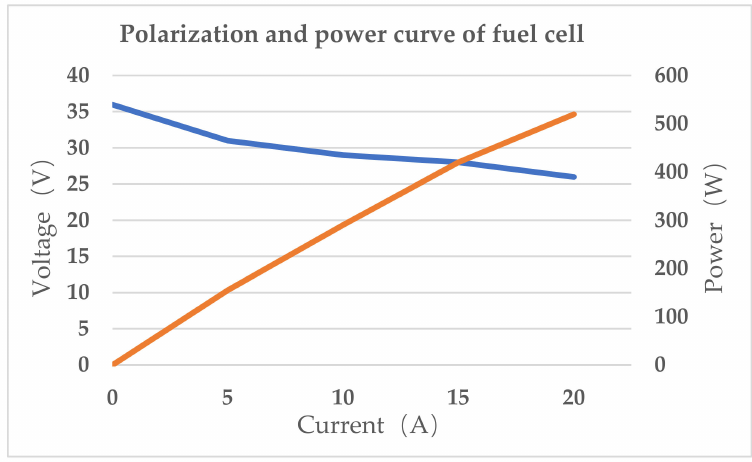
Figure 1. Polarization and power curve of each fuel cell stack.